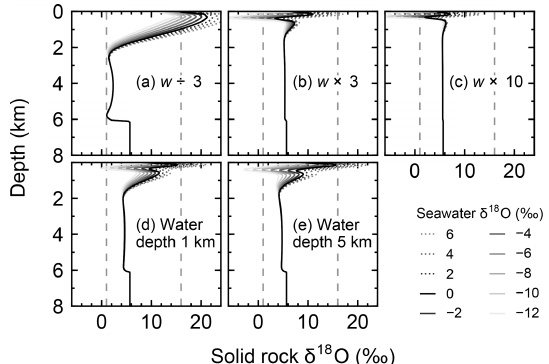
Figure 8. Solid rock δ 18 O as a function of depth at 30km from the ridge axis at seawater δ 18 O values of 6, 4, ..., − 12‰ from sim- ulations with different spreading rates and ocean depths. Broken lines denote 1‰ and 16‰ between which observed δ 18 O of ophi- olites and/or oceanic crust ranges (Gregory and Taylor, 1981; Bar- rett and Friedrichsen, 1982; Cocker et al., 1982; Elthon et al., 1984; Alt et al., 1986, 1995; Agrinier et al., 1988; Schiffman and Smith, 1988; Vibetti et al., 1989; Lécuyer and Fourcade, 1991; Stakes, 1991; Bickle and Teagle, 1992; Holmden and Muehlenbachs, 1993; Muehlenbachs et al., 2003; Alt and Bach, 2006; Furnes et al., 2007; Gao et al., 2012). Standard parameter values are assumed, except for the parameterization denoted at each